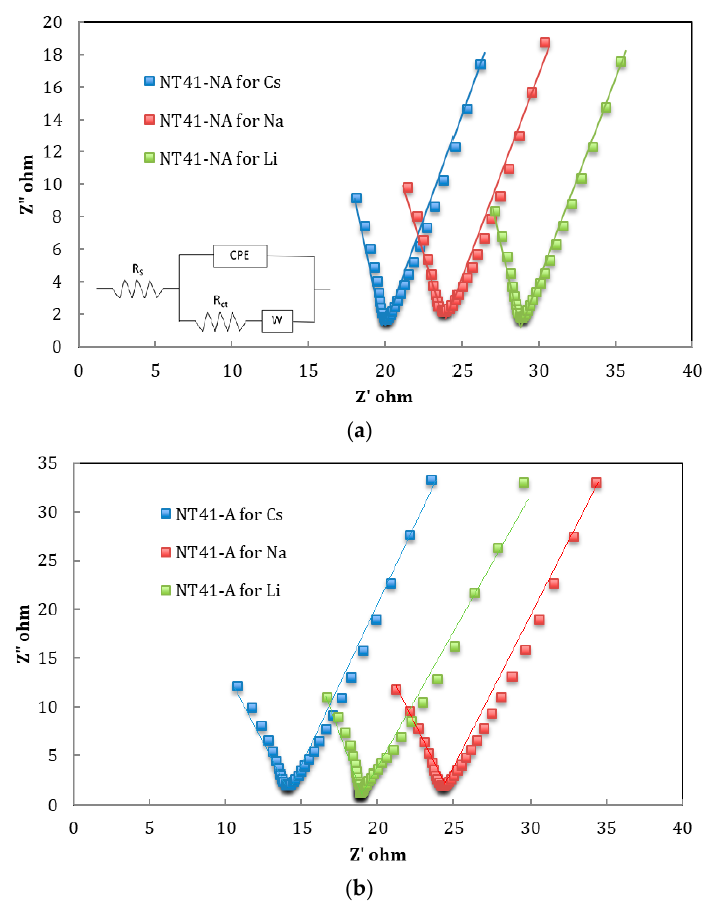
Figure 5. Nyquist plots for ( a ) TiO 2 NT-NA and ( b ) TiO 2 NT-A. The solid lines are the modeling